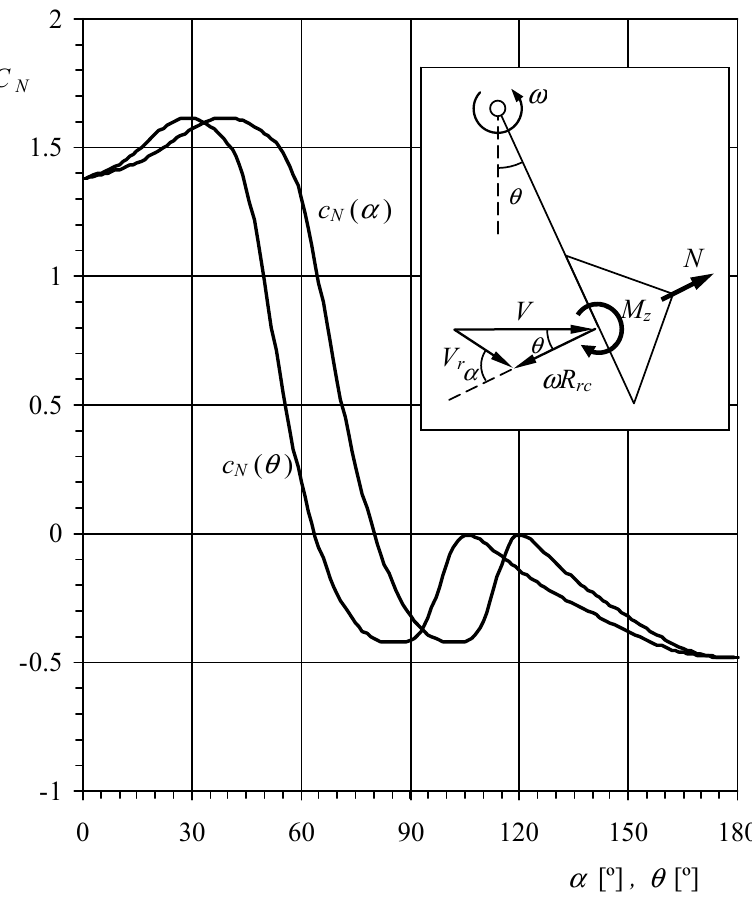
Figure 4. Normal aerodynamic force coefficient, c cup plotted as a function of the wind direction with respect to the cup, α , and the rotor’s rotation angle, θ . Calculated for anemometer factor K =